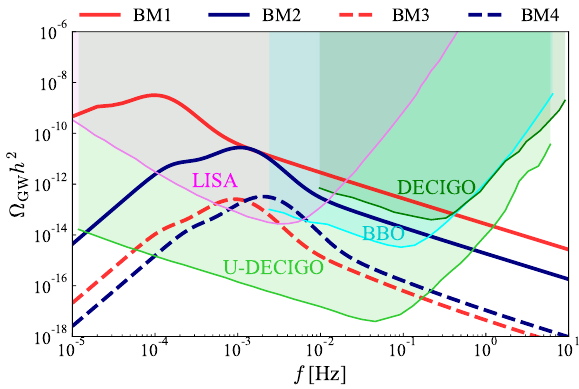
Figure 6 . GW energy density fraction as a function of the frequency for BM1 (solid red), BM2 (solid blue), BM3 (dotted red), and BM4 (dotted blue). The colored regions are observable areas by future space-based